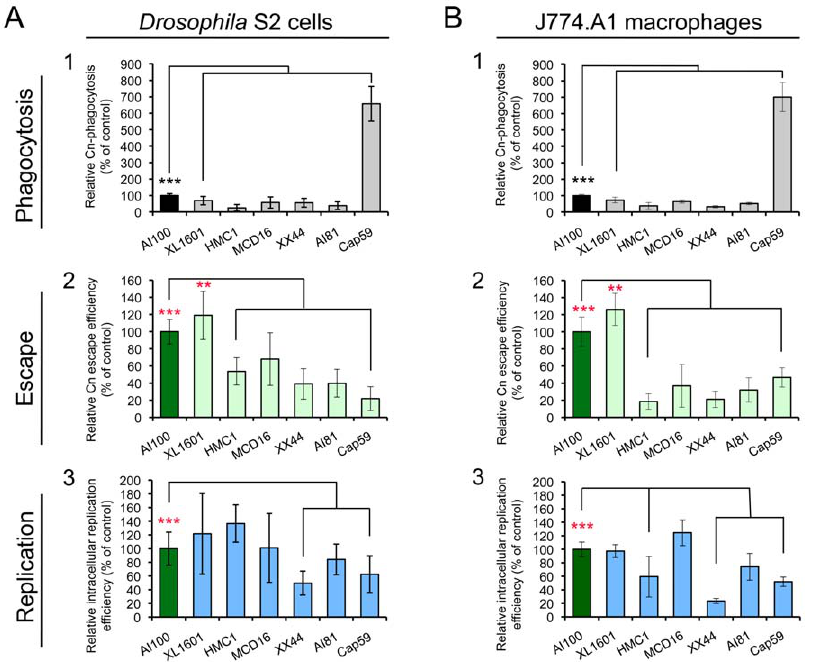
Figure 4. Cryptococcusneoformans mutants behave similarly in Drosophila S2 cells. ( A ) and murine J774.A1 macrophages ( B ). Host cells were infected with the following Cn strains: AI100-dsRed, XL1601, HMCA1, MCD16, XX44, AI81 and Cap59. The infected cells were then extensively washed at 3 h.p.i. and then fresh medium supplemented with 20 m g/ml fluconazole was added to each well. The infected cells were continuously incubated at 28 u C (S2 cells) or at 37 u C, 5% CO 2 (J774.A1 cells). At 3 and 15 h.p.i., the number of Cn cells present in the supernatant or within host cells was determined as described in the Materials and Methods section. Cn mutants display similar internalization patterns ( A1 and B1 ), levels of Cn escape ( A2 and B2 ) and relative intracellular replication efficiencies ( A3 and B3 ) in S2 ( A , left panel) and J774.A1 ( B , right panel) cells. Data from the control (AI100-dsRed) were normalized to 100%. Data represent the means 6 SD from at least three independent experiments. **, *** indicates significance at P , 0.01 and P , 0.001,